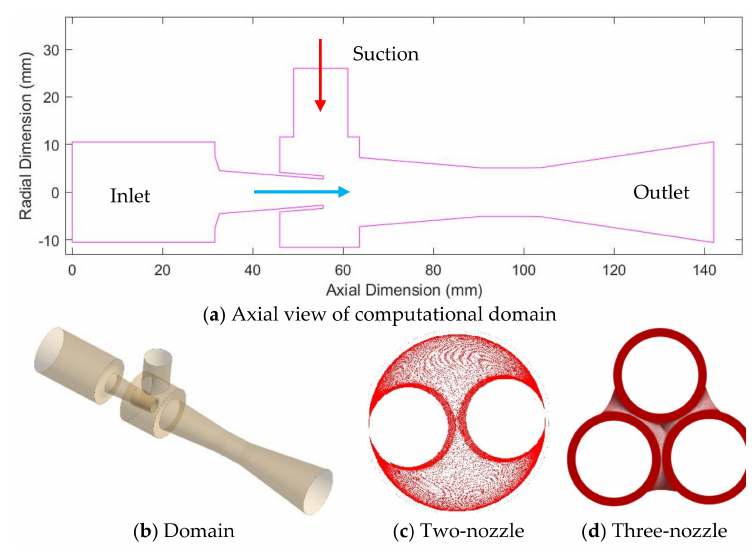
Figure 5. Geometry